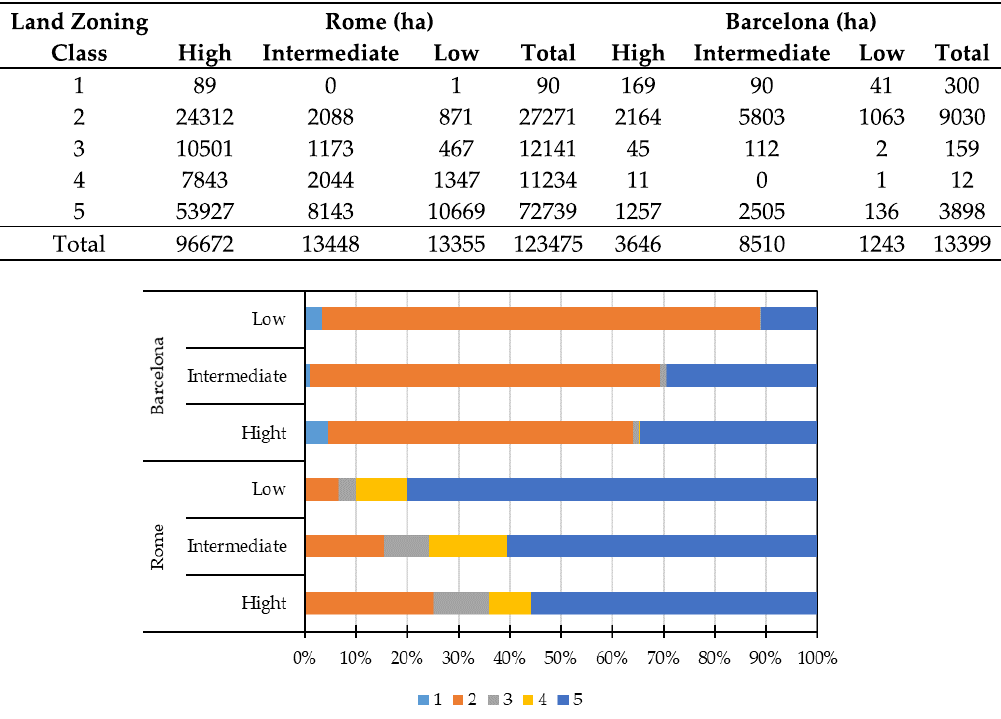
Figure 3. Soil quality index (SQI) values represented by zoning classes 1–5 (see Table 1) in hectares (upper table) and percentages (bar plot) in Rome and Barcelona.